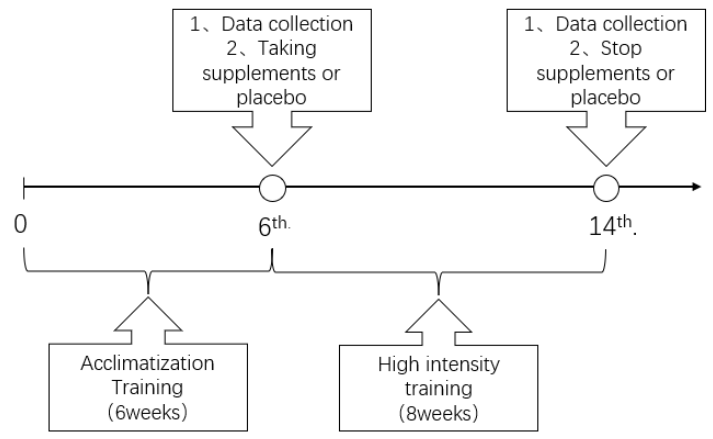
Figure 2. The timeline of the